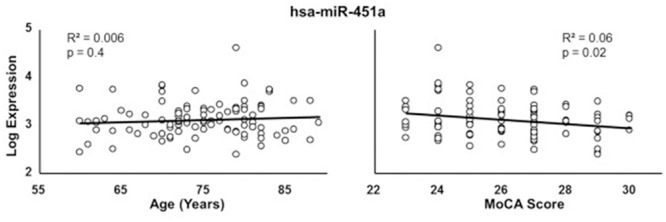
Correlation of hsa-miR-451a with age (left) or MoCA scores (right).